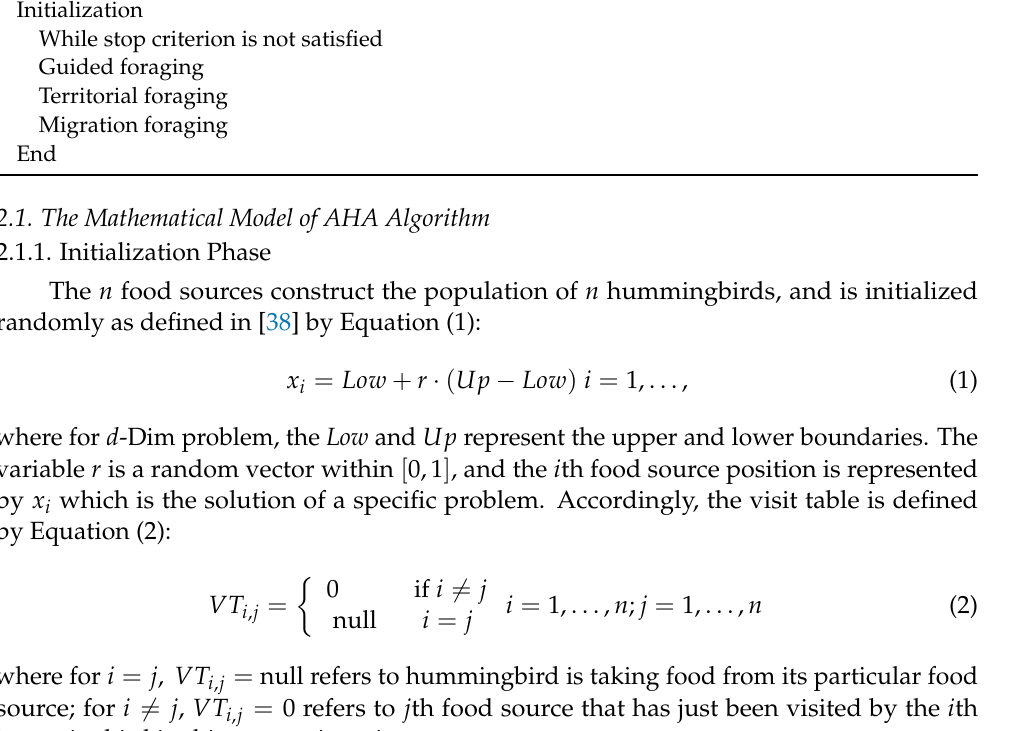
Algorithm 1: Structure of